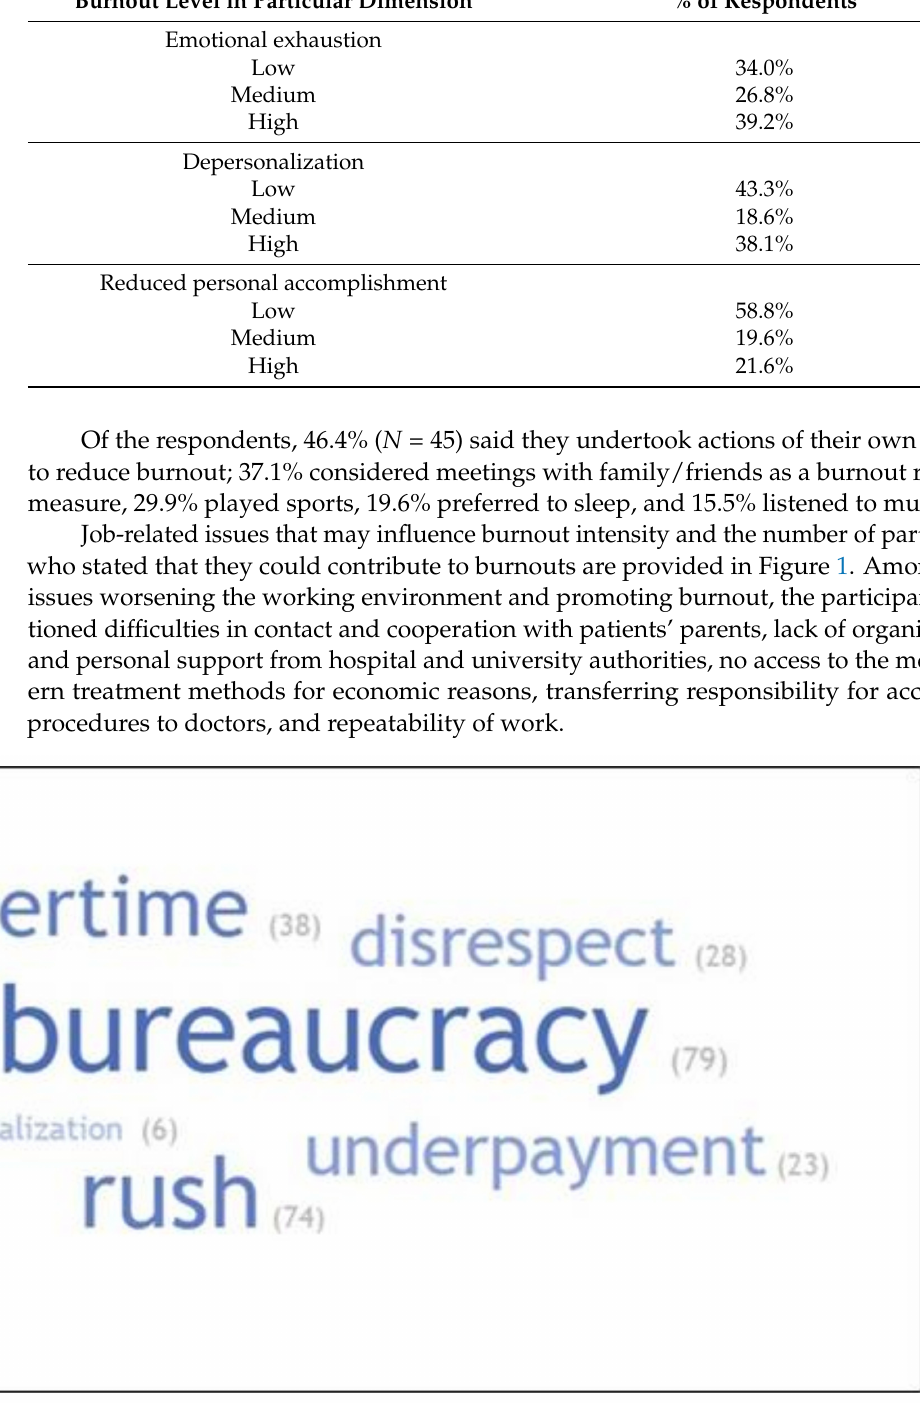
Figure 1. A word cloud presenting job-related issues influencing burnout intensity among pediatric nephrologists. The more a specific factor appeared in the database, the bigger and bolder it appears in the word